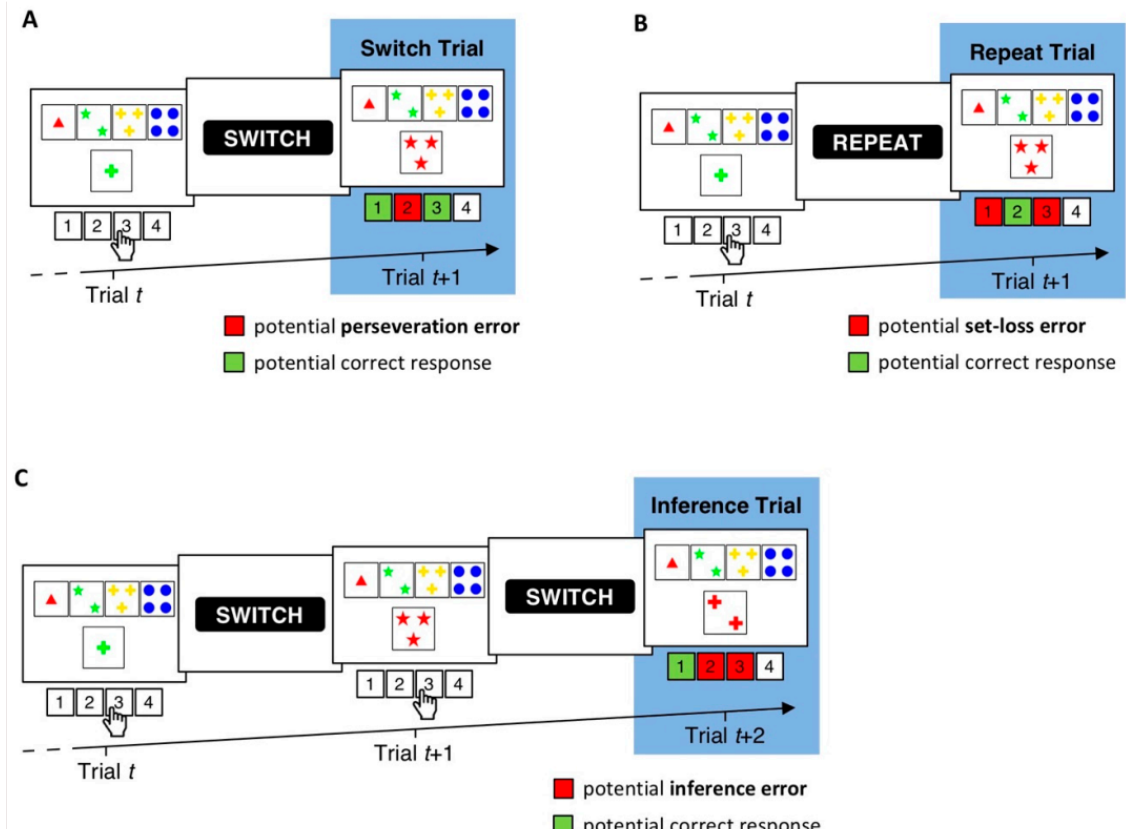
Figure 1. Exemplary trial sequences on a computerized variant of the WCST (i.e., the cWCST) [25]. ( A ). The stimulus card on Trial t depicts one green cross. Applicable cognitive sets are the number category (far left key card, response 1), the color category (inner left key card, response 2), and the shape category (inner right key card, response 3). The execution of response 3 indicates the application of the shape category. A succeeding negative feedback cue (i.e., “SWITCH”) indicates that response 3 was incorrect and that the shape category should be switched on the upcoming trial. Trial t + 1 therefore constitutes a switch trial. Perseveration errors are erroneous repetitions of the applied cognitive set on switch trials (e.g., the shape category on trial t + 1). ( B ). Trial t depicts the same stimulus card and response as in A. However, the application of the shape category is now followed by a positive feedback cue (“REPEAT”), indicating that the execution of response 3 was correct and that the shape category should be repeated on the upcoming trial. Set-loss errors are erroneous switches of the applied cognitive set on repeat trials (e.g., the color or number category on Trial t + 1). ( C ). On Trial t , the execution of response 3 indicates the application of the shape category, which is followed by a negative feedback cue. The execution of response 3 on Trial t + 1 indicates a switch to the number category. A subsequently presented negative feedback cue indicates that response 3 was incorrect and that the number category should also be switched. On trial t + 2, the participant received all necessary information to infer the prevailing category (i.e., sorting by the shape and the number category were incorrect; thus, the application of the color category must be correct). Hence, trial t + 2 constitutes an inference trial [22–24]. Failures to infer the prevailing cognitive set (as indicated by the application of any other category than color on trial t + 2) are scored as inference